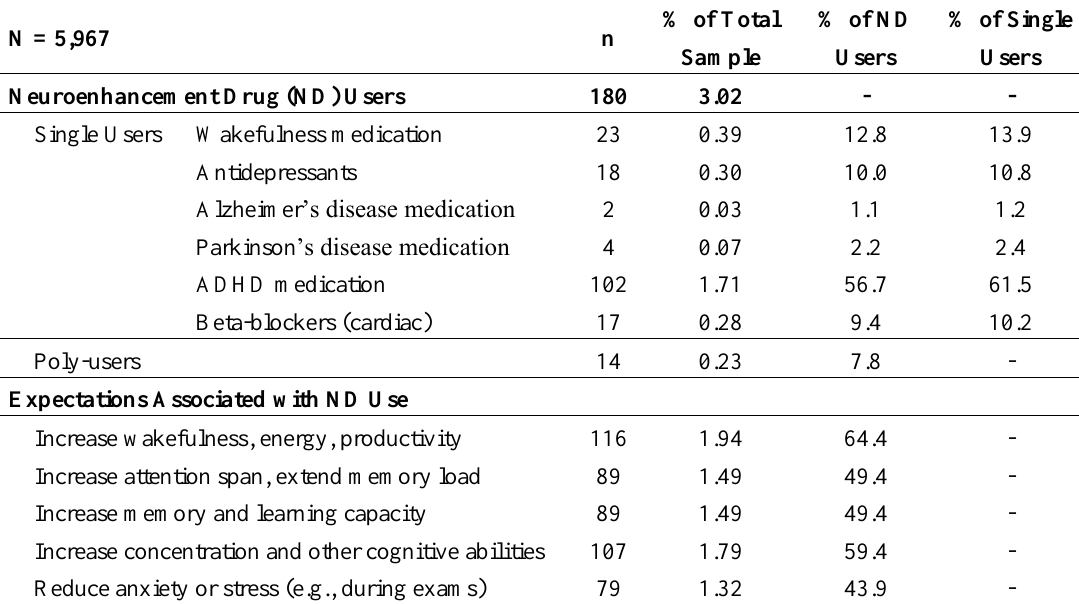
Table 1. Prevalence rates of neuroenhancement drug use, and neuroenhancement use expectations among